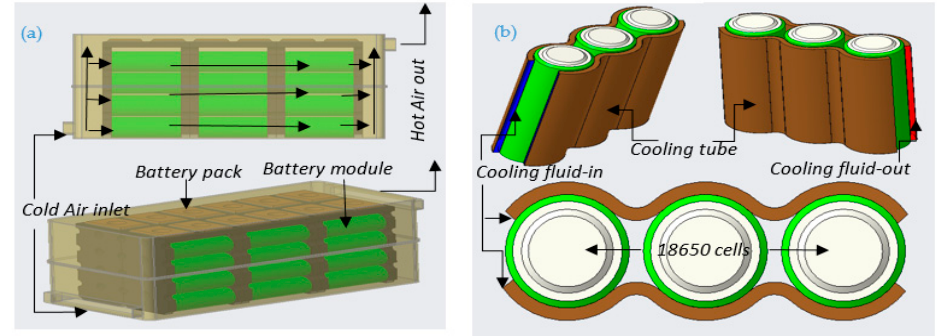
Figure 2. ( a ) Examples of a cylindrical cell air cooling system and ( b ) a cylindrical LIBs liquid cooling methods .